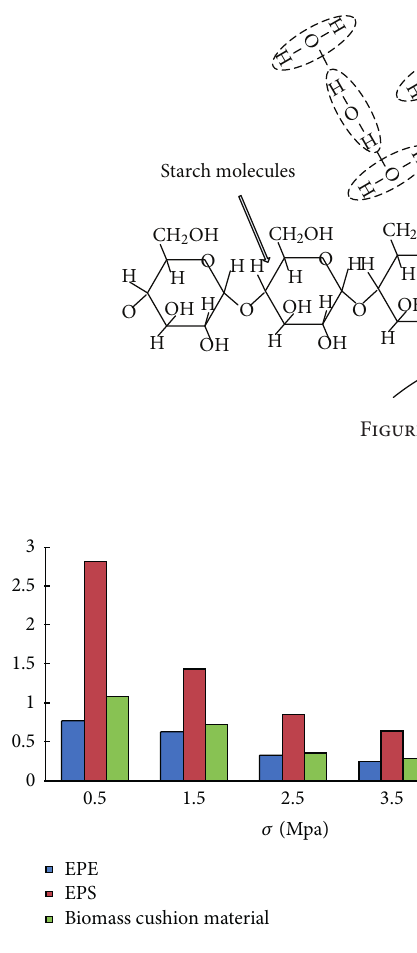
Figure 6: Relationship between cushion coefficients and stresses of different packaging materials.